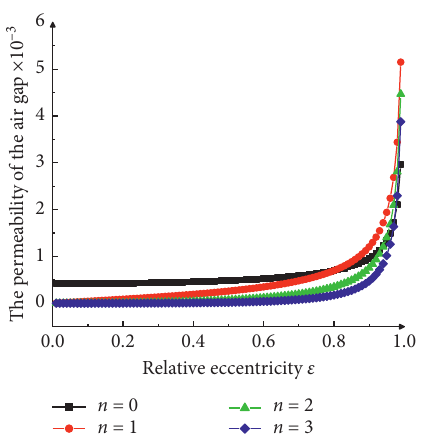
Figure 4: The relation between relative eccentricity and air gap permeability coefficient.